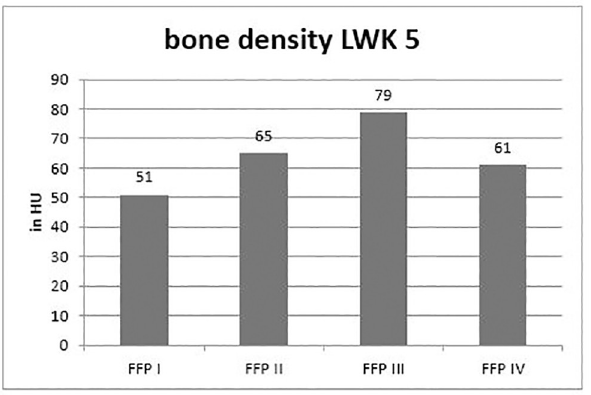
Fig 3. Distribution of patients bone mineral density in L5 according to the fragility fracture of the pelvis classification according to Rommens in CT.